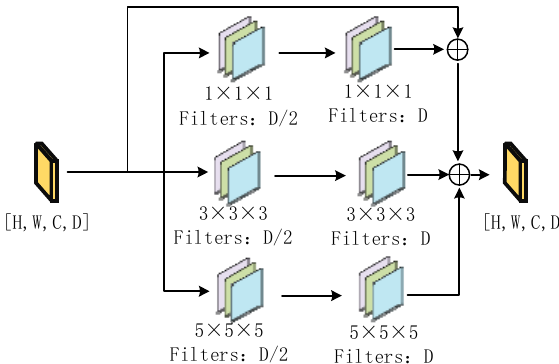
Figure 2. Multi-scale feature fusion module.